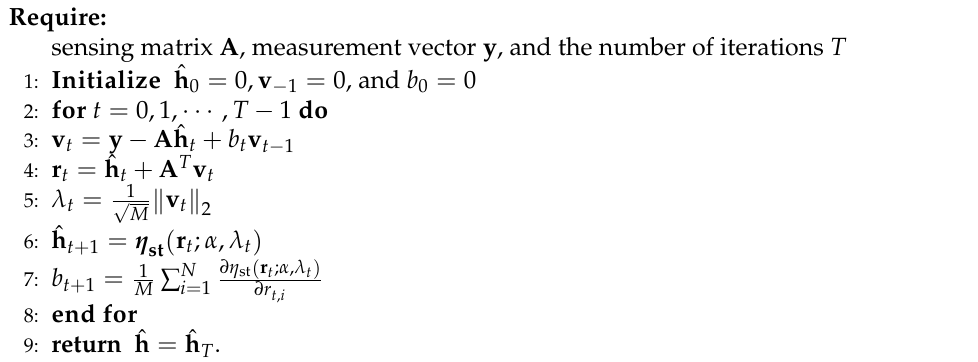
Algorithm 2 AMP Algorithm in mmWave